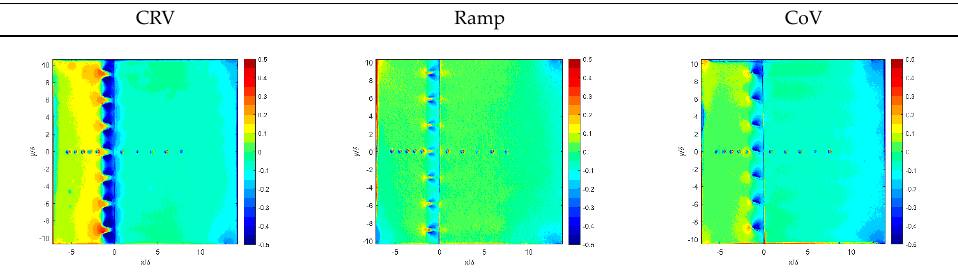
Figure 7. Global surface pressure pattern for M = 0.64 and h* = 1.0.